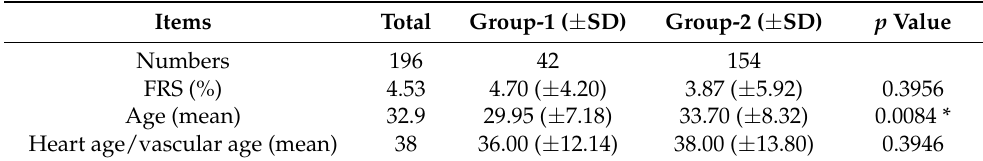
Table 5. Cardiovascular risk among naïve and HAART participants ( n =